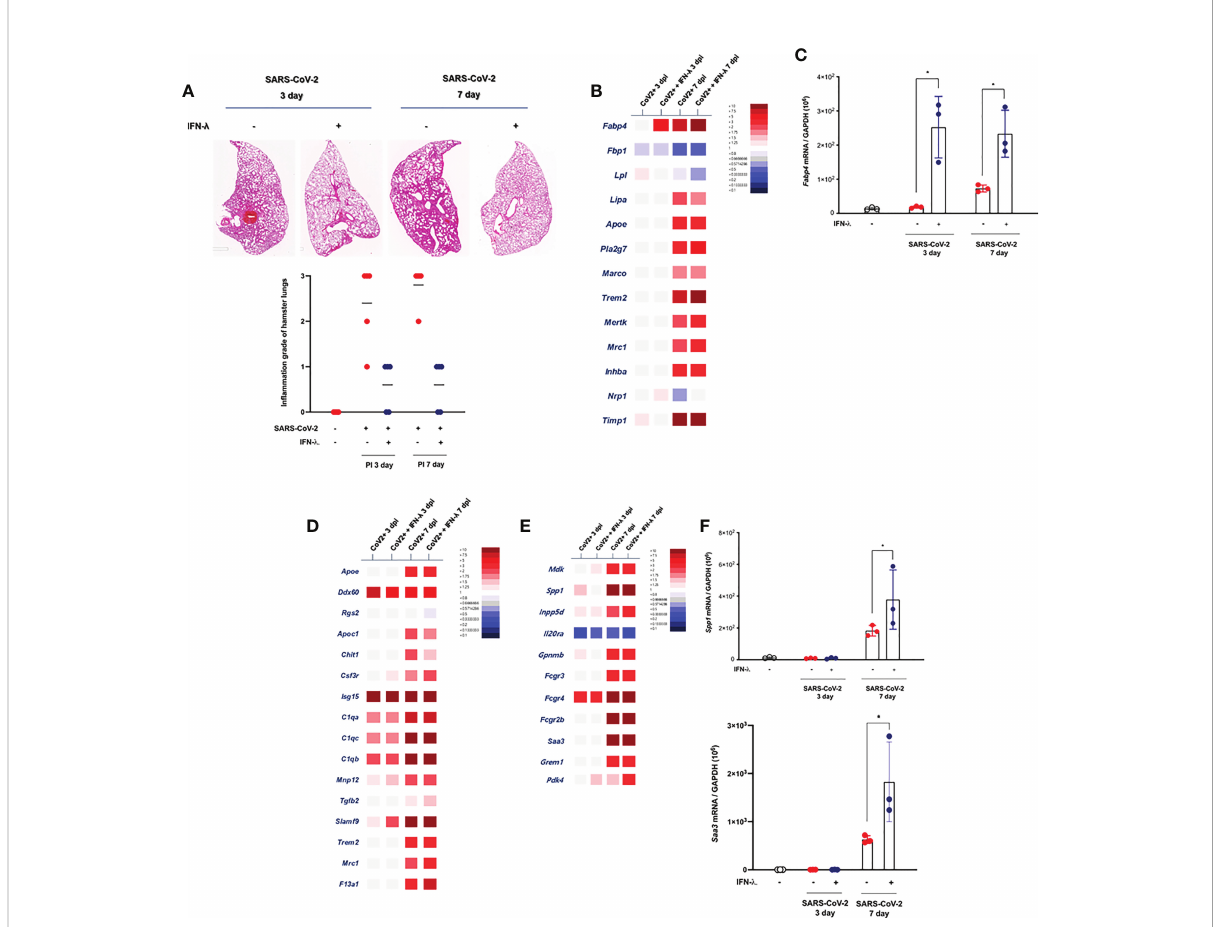
FIGURE 6 Intranasal inoculation of IFN- l resolves the lung damages in CoV2+ hamsters. (A) Lung tissue samples were obtained from SARS-CoV-2-infected hamsters at 3 and 7 dpi, and the whole-lung microscopic fi ndings were compared according to IFN- l inoculation [CoV2- (N = 3)/CoV2+ 3 dpi (N